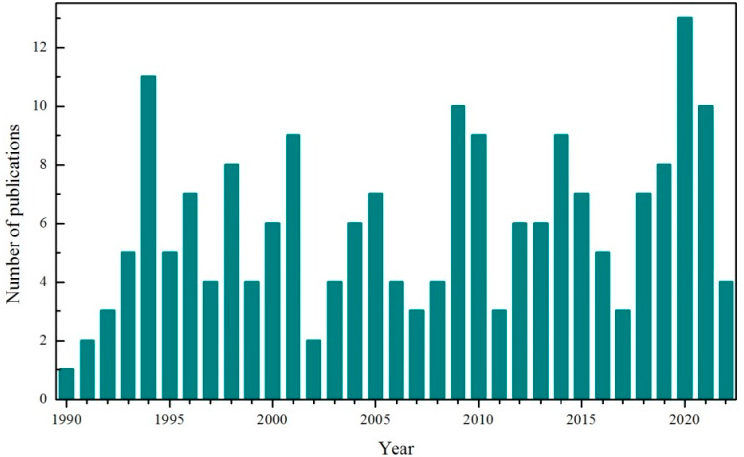
Figure 1. Number of publications on Ga 2 O 3 -based gas sensors from 1990 to 2022. Data extracted from Web of Science with keywords “sensor” or “sensing” and “Ga 2 O 3 ” or “gallium oxide”.